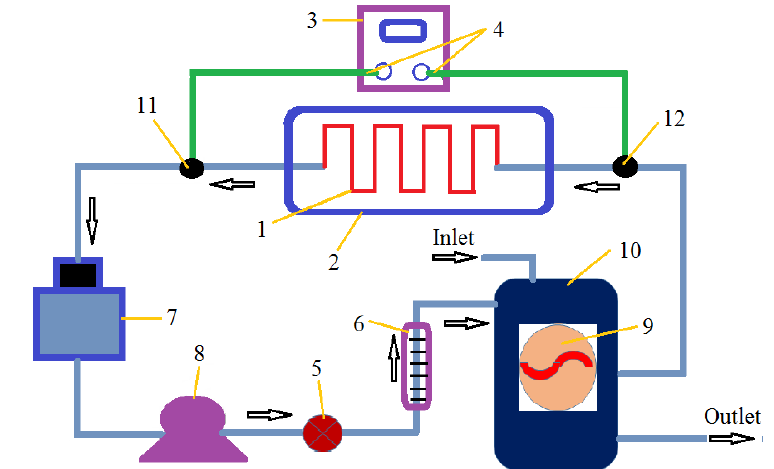
Fig. 11. Experimental setup. (1) Copper coil, (2) cylindrical glass, (3) datalogger system, (4) thermocouple wires, (5) line valve, (6) rotameter, (7) water supply and drainer, (8) water pump, (9) heat exchanger, (10) reservoir tank and (11 and 12) thermocouples